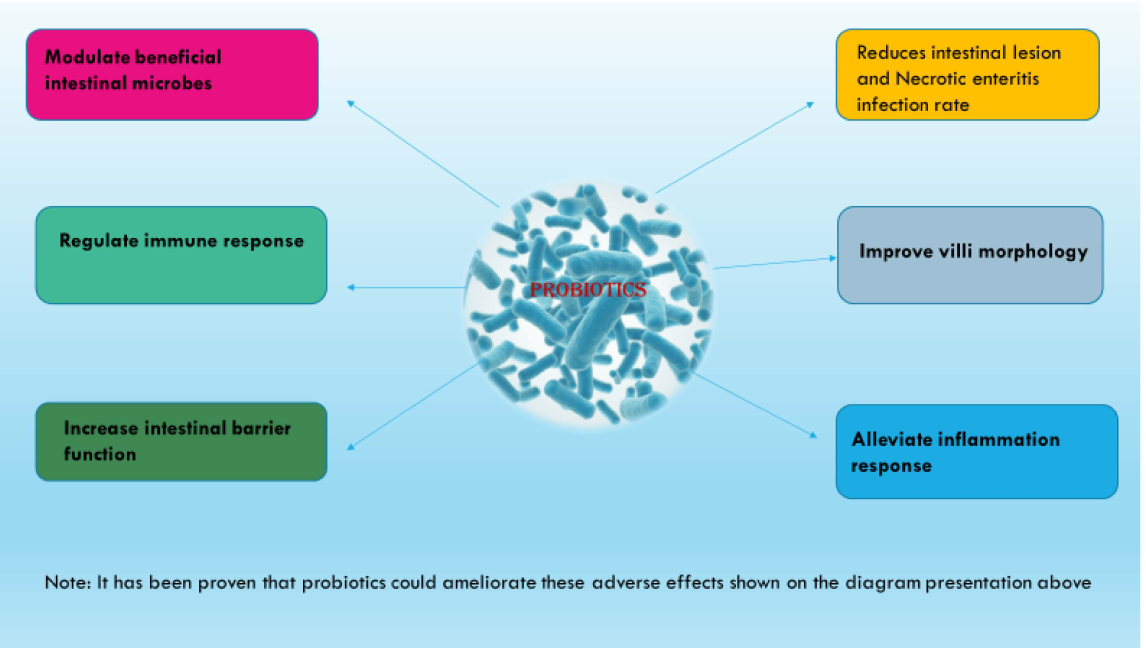
Figure 3. Mechanisms by which probiotics exert mitigative effects on gut health of birds exposed to NE